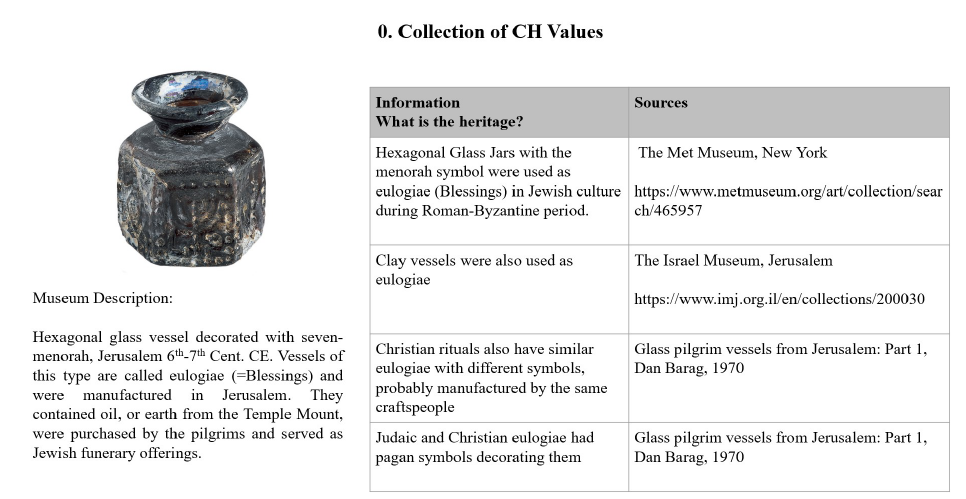
Figure 2. Collection of CH information and their sources for the ‘Glass jar’ artefact in the Meno- rah